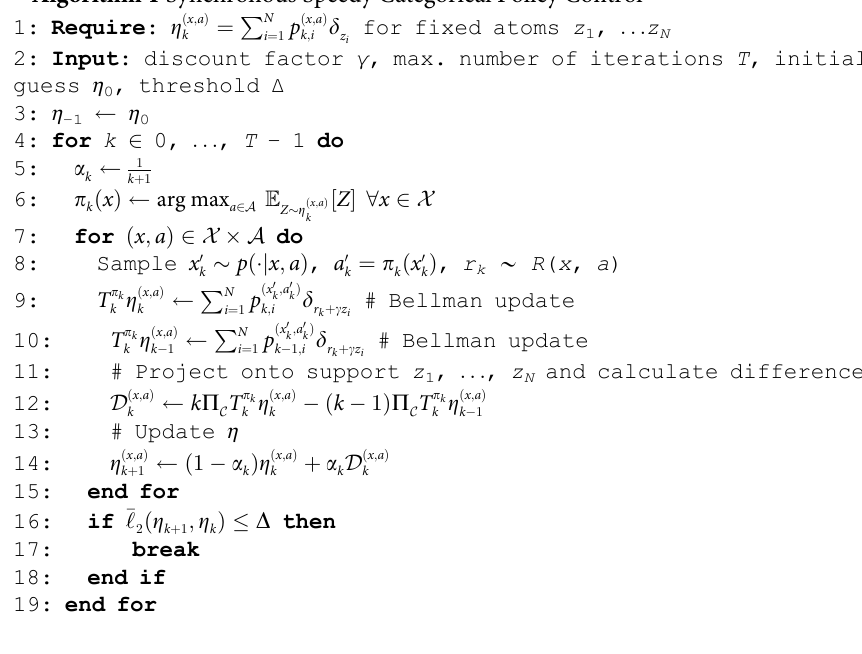
Algorithm 1 Synchronous Speedy Categorical Policy